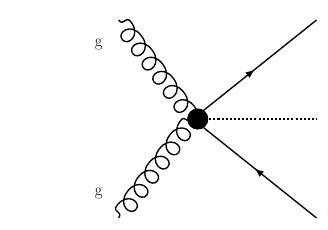
Figure 2 . Example diagrams showing two of the vertices associated with the O operator, whose definition can be found in table 1, gives rise to vertices involving top quarks, gluons, and the Higgs boson; as illustrated here, these interactions can contribute to the ttH